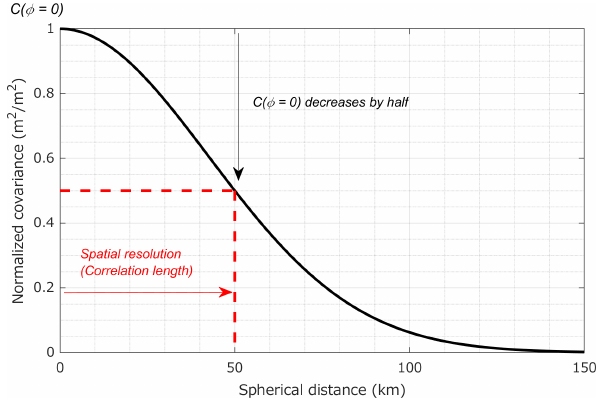
Figure 4. The concept used to determine spatial resolution (corre- lation length). The spatial resolution is defined to be the spherical distance φ at which the 0km covariance (or normalized covariance), C(φ = 0 ) decreases by